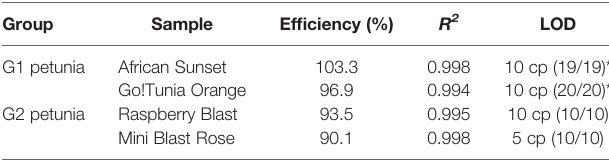
TABLE 4 | Ef fi ciency, R 2 and LOD for G1 and G2 petunia event-speci fi c real- time PCR